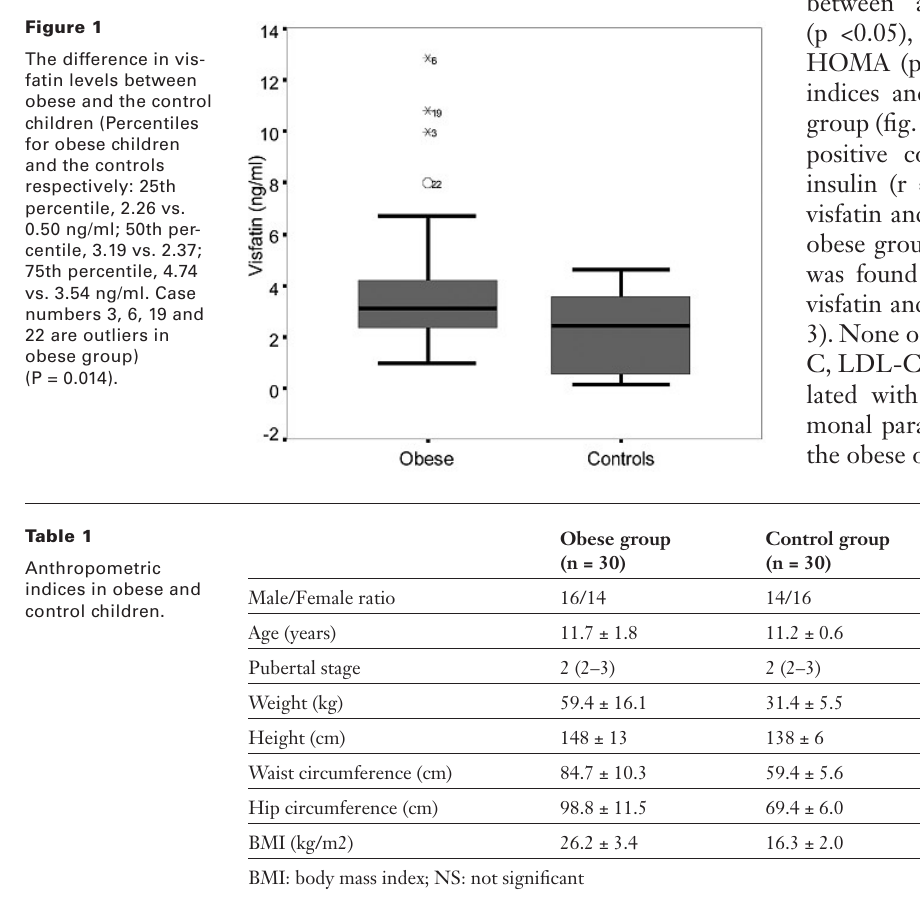
Laboratory values in obese children and the control group.